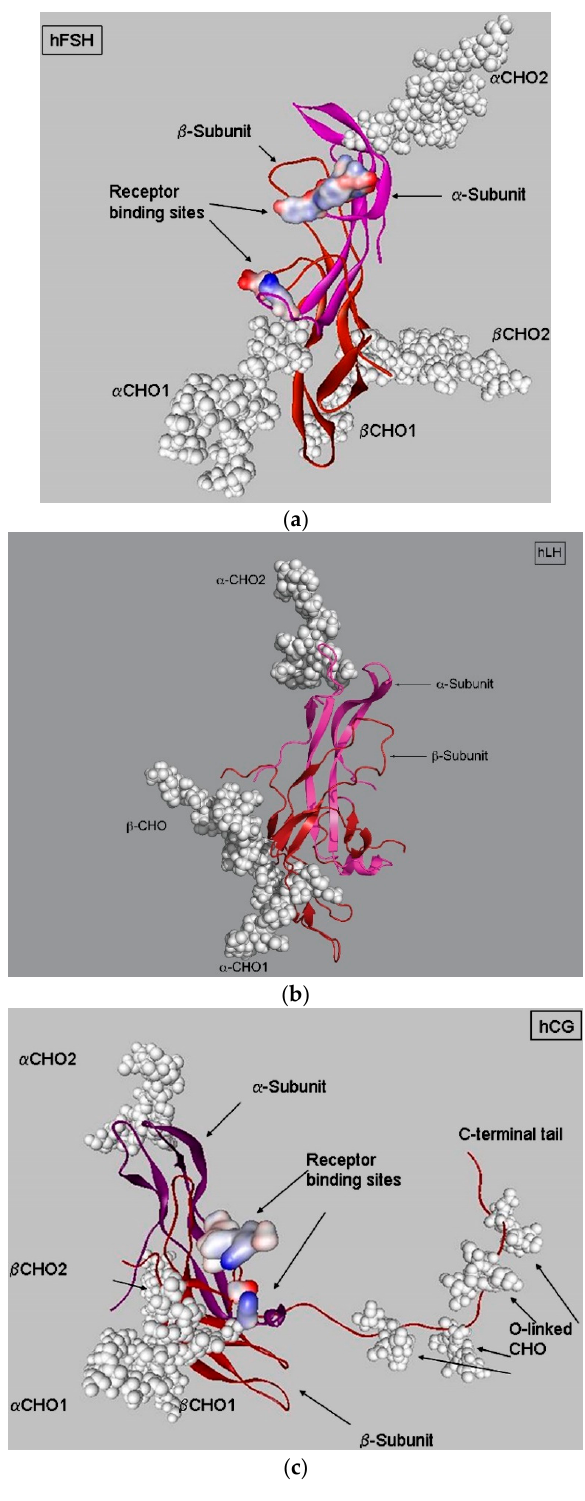
Figure 3. Structures of follicle-stimulating hormone (FSH) ( A ), and luteinizing hormone (LH) ( B ), and human chorionic gonadotropin (hCG) ( C ) showing the α and β subunits of each hormone. When compared to human LHRs (hLHs), the β subunit of hCG has additional amino acids and extensive glycosylation on the C-terminal tail that contribute to its higher molecular weight. FSH and hCG structures were from reprinted from [24] with permission from Elsevier. The figure of hLHs shown in the middle panel was provided by Dr. George